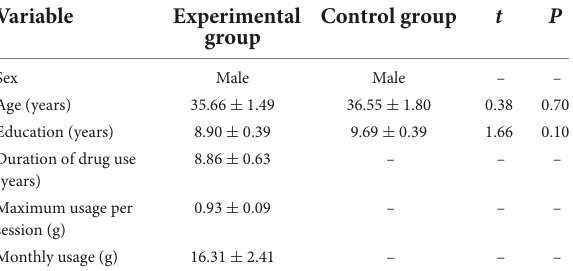
TABLE 1 Participants’ demographic characteristics ( M ± SEM